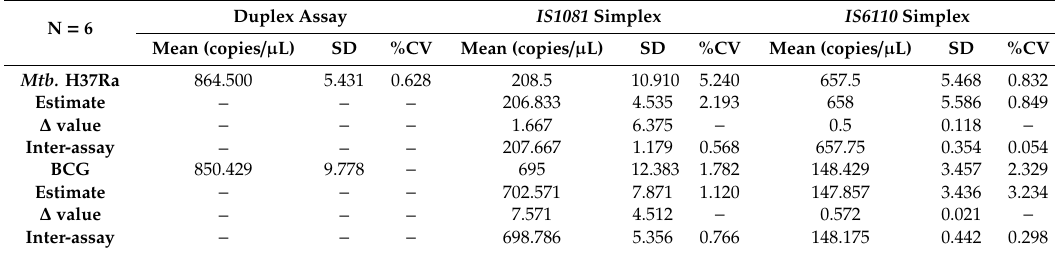
Table 1. Analysis of simplex and duplex assays in replicate wells. Mtb. H37Ra and BCG represent the actual values read on the machine when both the simplex assay and duplex assay were run. Estimate is an approximated value calculated using the threshold tool to quantify the concentration of various genes in a duplex assay. Mtb. H37Ra ( Mycobacterium tuberculosis H37Ra), BCG ( Mycobacterium bovis BCG).